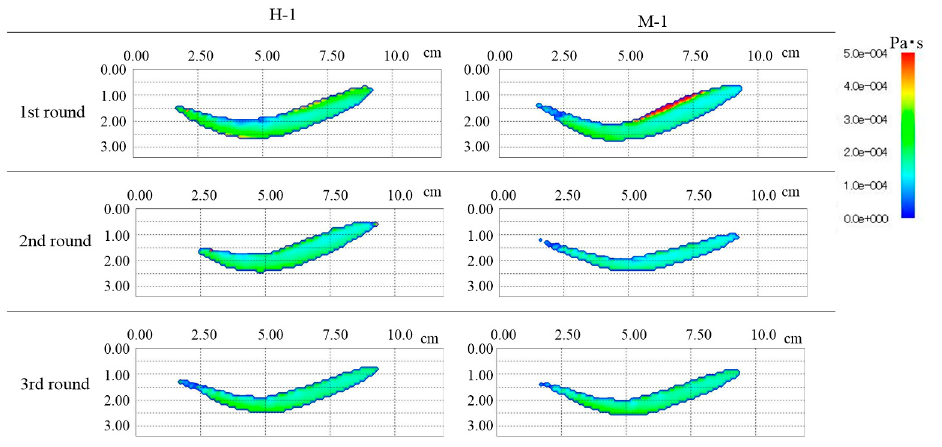
Figure 18. Distribution of the viscosity coefficient from the simulation results.